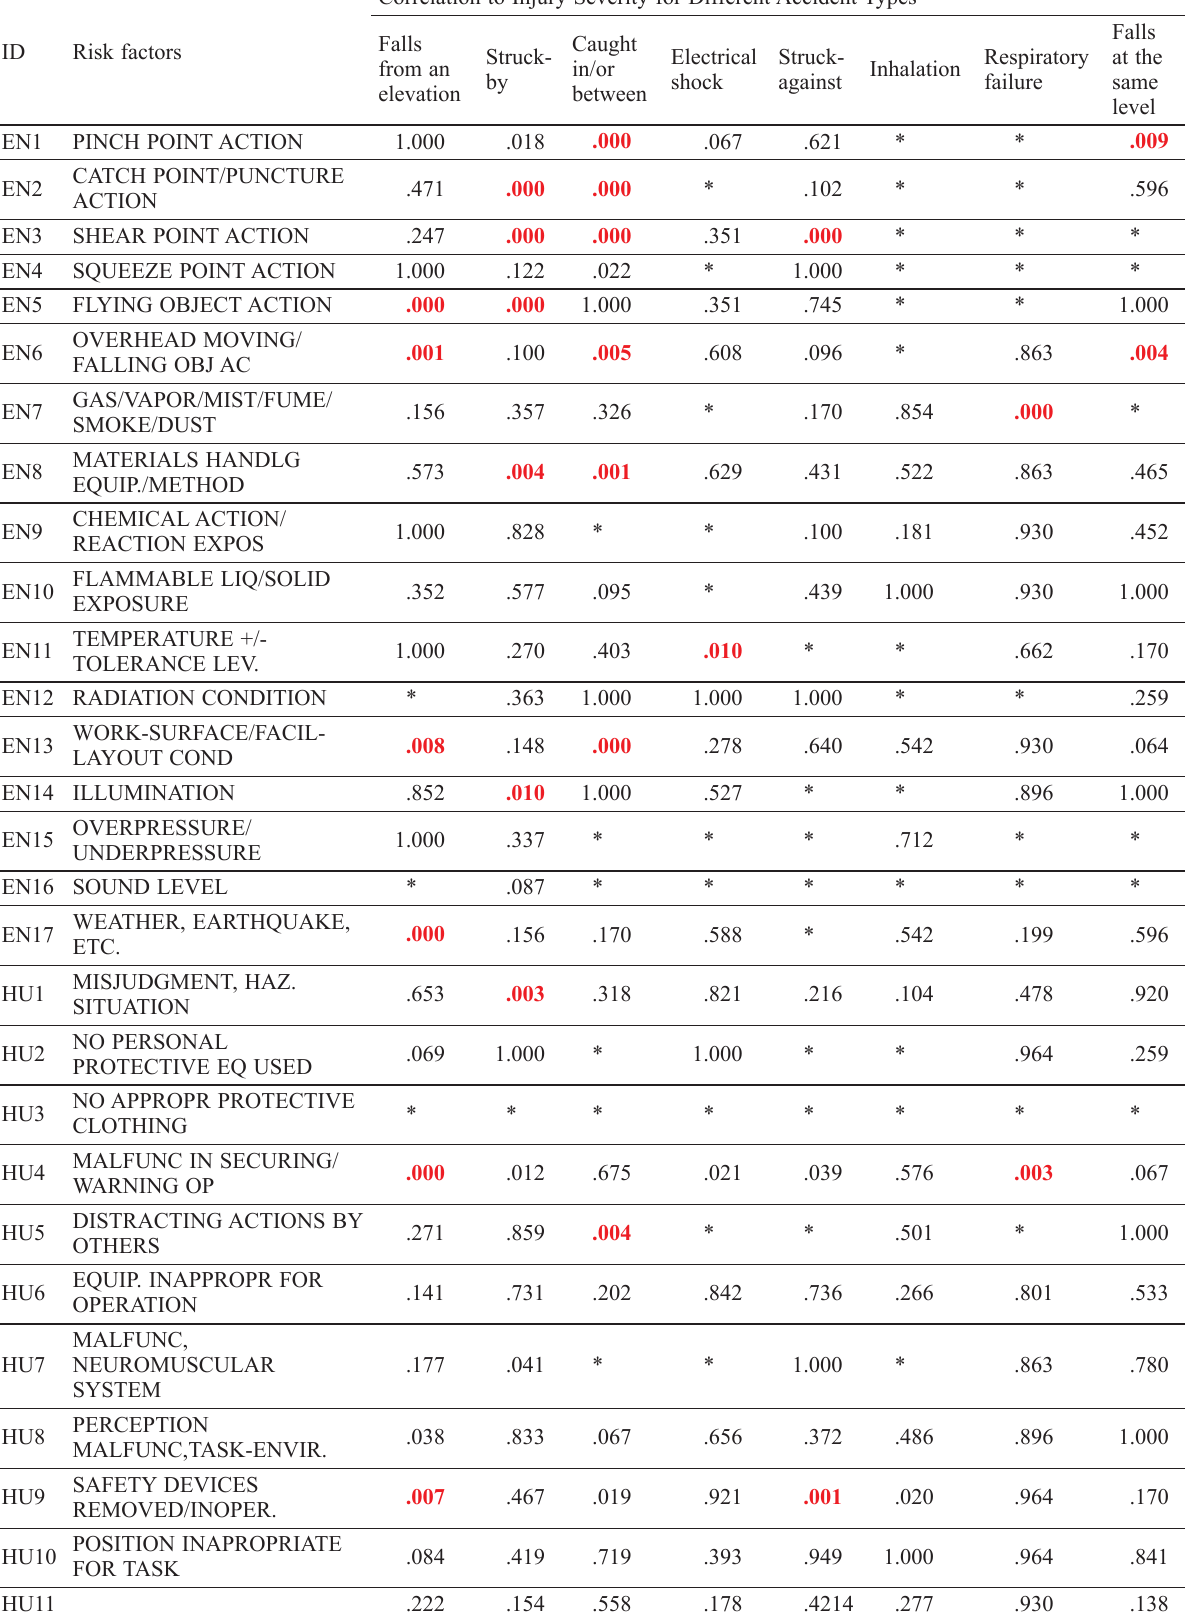
Table 5. Significant risk factors and their correlation to injury severity